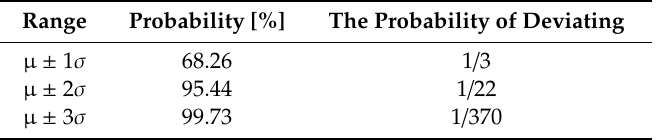
Figure 4. Distribution curve about statistics.